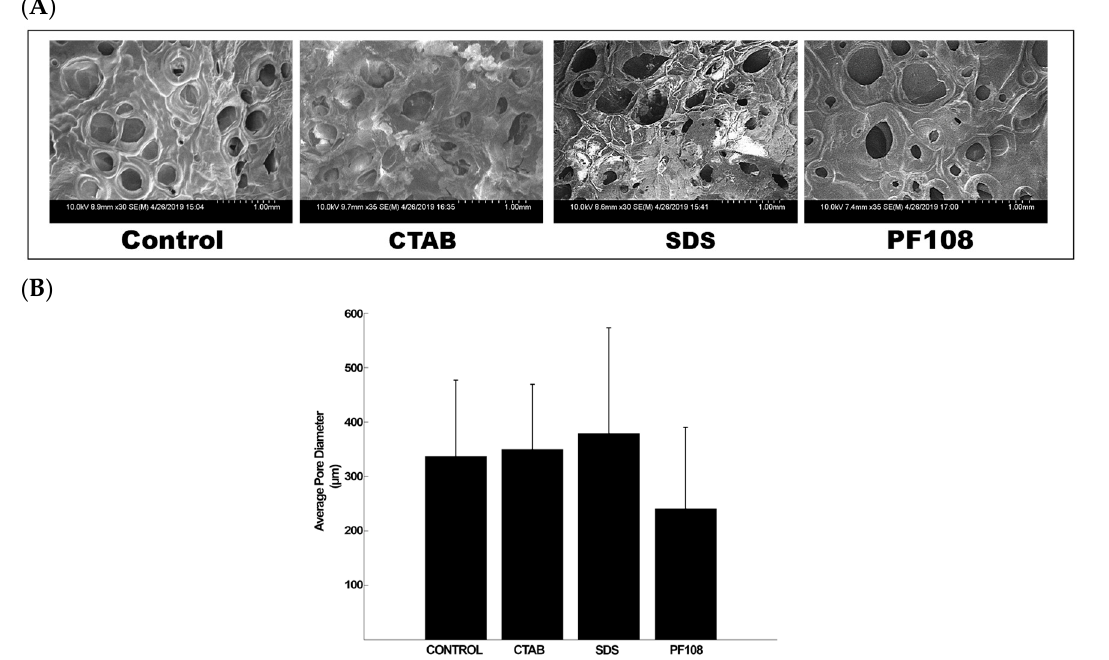
Figure 5. Characteristic SEM images ( A ) and average pore size distribution ( B ) of different surfactant/SWCNT-based hydrogels.